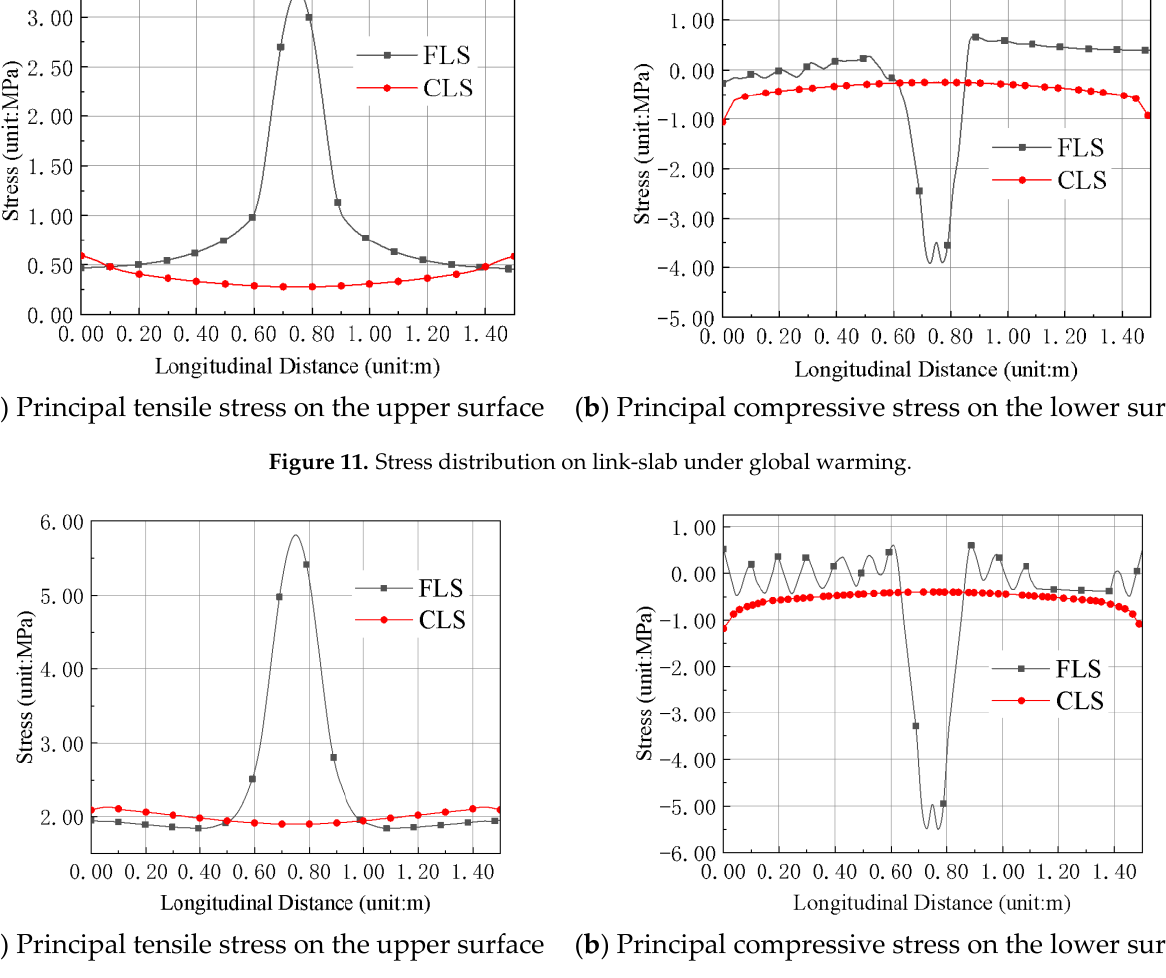
Figure 12. Stress distribution on the link-slab under negative temperature gradient.